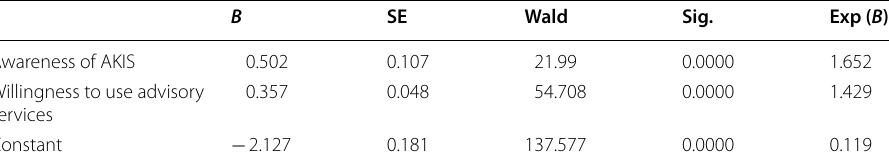
Table 2 Results of logit model